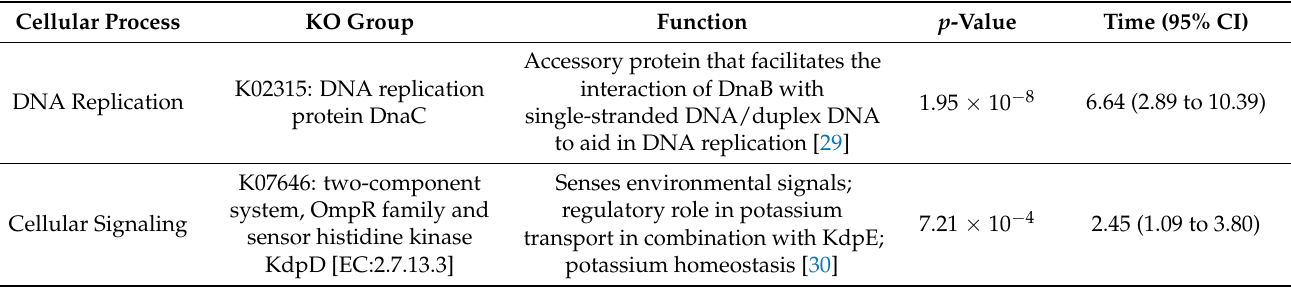
Table 1. KO Groups that increased